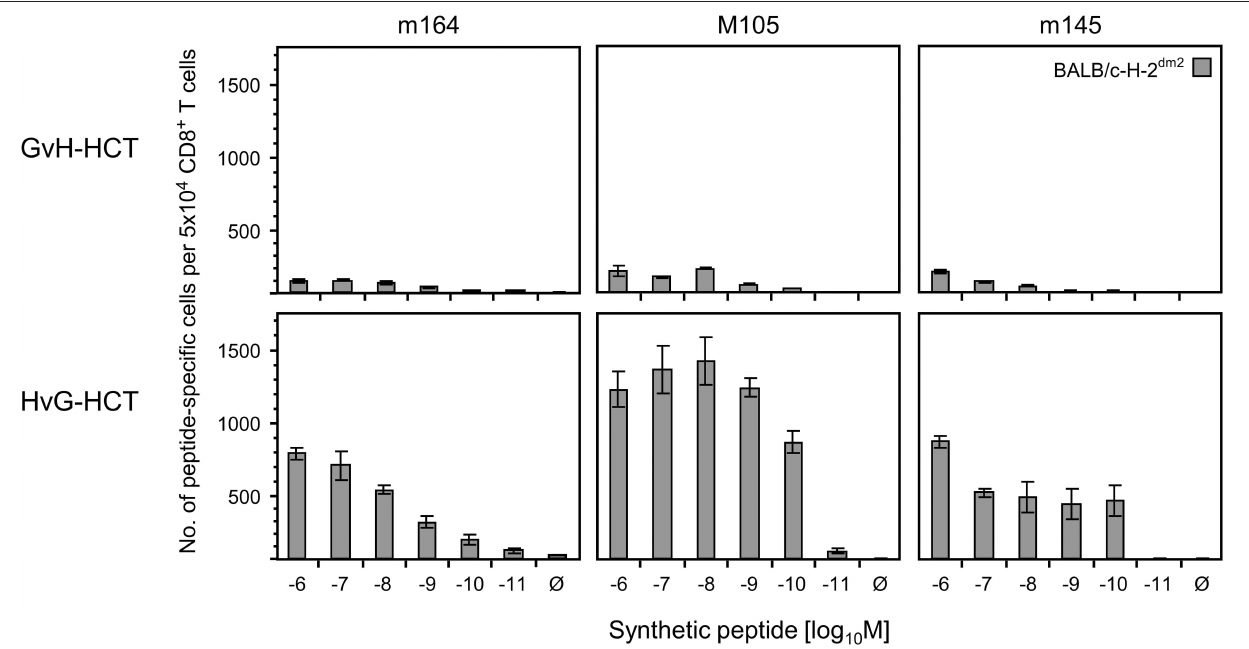
FIGURE 7 | Frequencies of viral epitope-specific liver-infiltrating CD8 + T cells after GvH-HCT compared to HvG-HCT. Liver-infiltrating CD8 + T cells derived on day 20 from livers (pools of 10 livers per group) of GvH-HCT recipients (upper panels) and HvG-HCT recipients (lower panels) were tested for the recognition of the indicated viral epitopes by using BALB/c-H-2 dm2 MEF as target cells in order to avoid masking by responses to the L d mismatch. For further details, see the legend to Figure 6